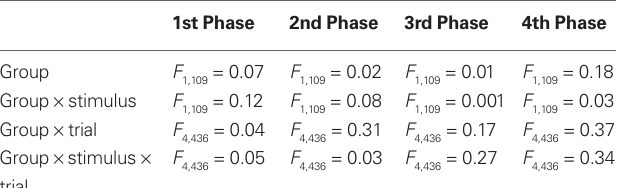
Table 2 | Fisher statistic values from repeated measurement ANOVA performed within conditioning phases to compare the performances of groups 1 and 2 (see Table 1). All values were non-significant so that performance of both groups could be